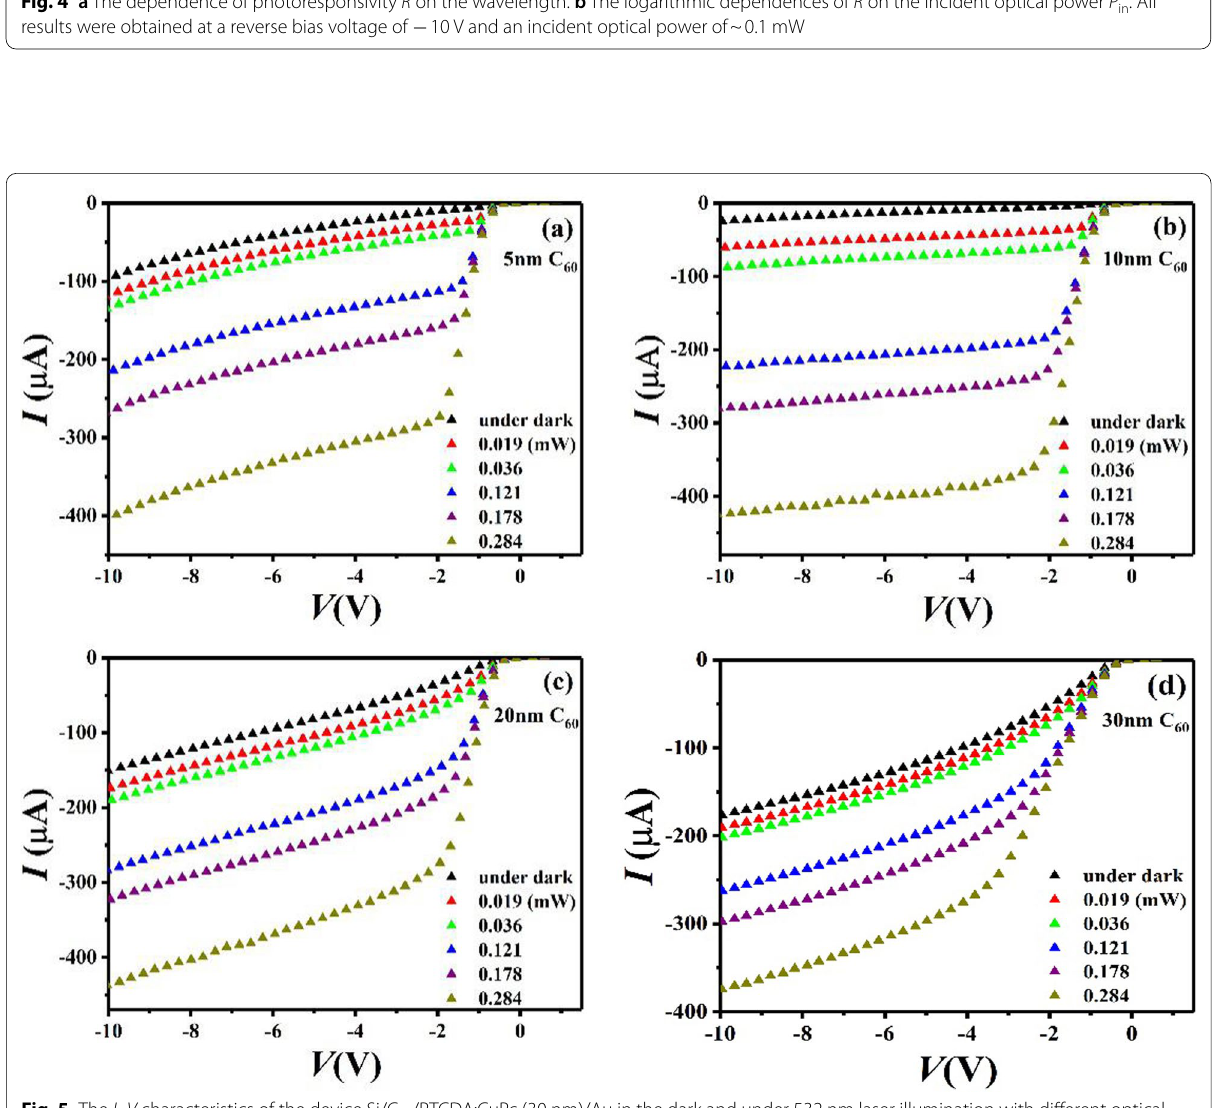
Fig. 5 The I – V characteristics of the device Si/C 60 /PTCDA:CuPc (30 nm)/Au in the dark and under 532 nm laser illumination with different optical power. The thicknesses of C 60 films are a 5 nm, b 10 nm, c 20 nm and d 30 nm,